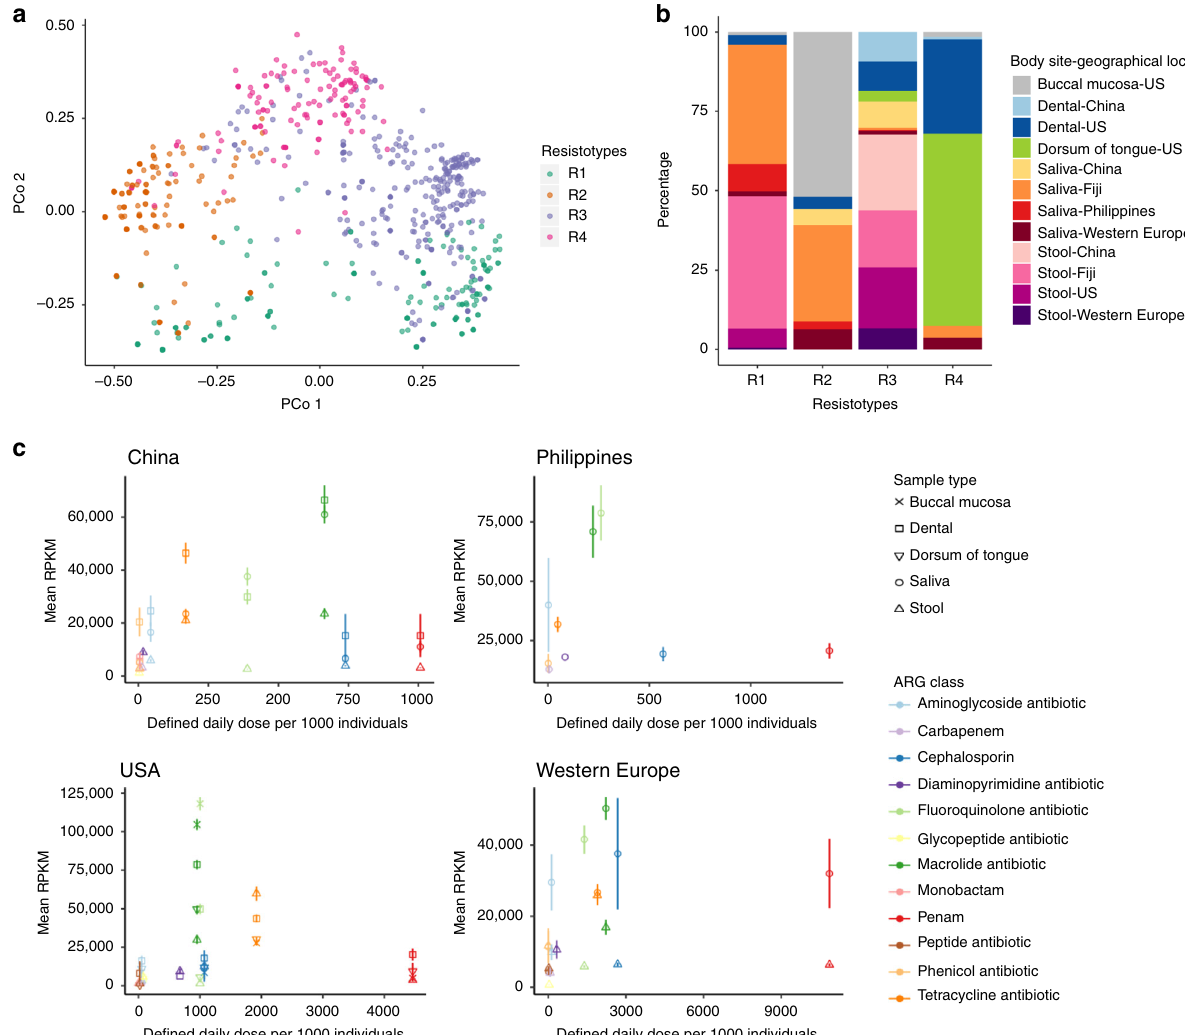
Fig. 2 Clustering of ARG incidence pro fi les into distinct groups, and comparing ARG abundance to antibiotic use. a Principal Coordinates Analysis of the incidence (presence/absence) of ARGs for all samples where each sample is represented by a point. Samples are labelled as Resistotype clusters, evaluated from hierarchical clustering of binary distance between ARG incidence pro fi les. The number of clusters was selected with the highest silhouette width using silhouette analysis. Samples from individuals from China (dental plaque: n = 29, saliva: n = 33, stool: n = 72), Fiji (saliva: n = 129, stool: n = 136), the Philippines (saliva: n = 22), the USA (buccal mucosa: n = 86, dental plaque: n = 80, dorsum of tongue: n = 91, stool: n = 70) and Western Europe (saliva: n = 21, stool: n = 21). b Percentage of resistotypes that contain samples from a body site and geographical location. c Mean and standard error (error bars) of reads per kilobase of read per million (RPKM) of ARGs for each ARG class against the de fi ned daily doses per 1000 individuals in 2015 from China, the Philippines, Western Europe (France and Germany) and the USA. (Fiji antibiotic use data unavailable.) Mean RPKM calculated from individuals from China (dental plaque: n = 32, saliva: n = 33, stool: n = 72), Philippines (saliva: n = 23), USA (buccal mucosa: n = 87, dental plaque: n = 90, dorsum of tongue: n = 91, stool: n = 70) and Western Europe (saliva: n = 21, stool: n = 21). Source data are provided in the Source Data fi